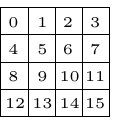
Figure 1: Cell numbering in a state of SKINNY